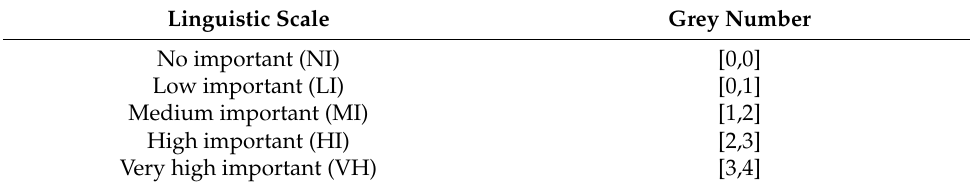
Table 3. Linguistic scale and grey number.